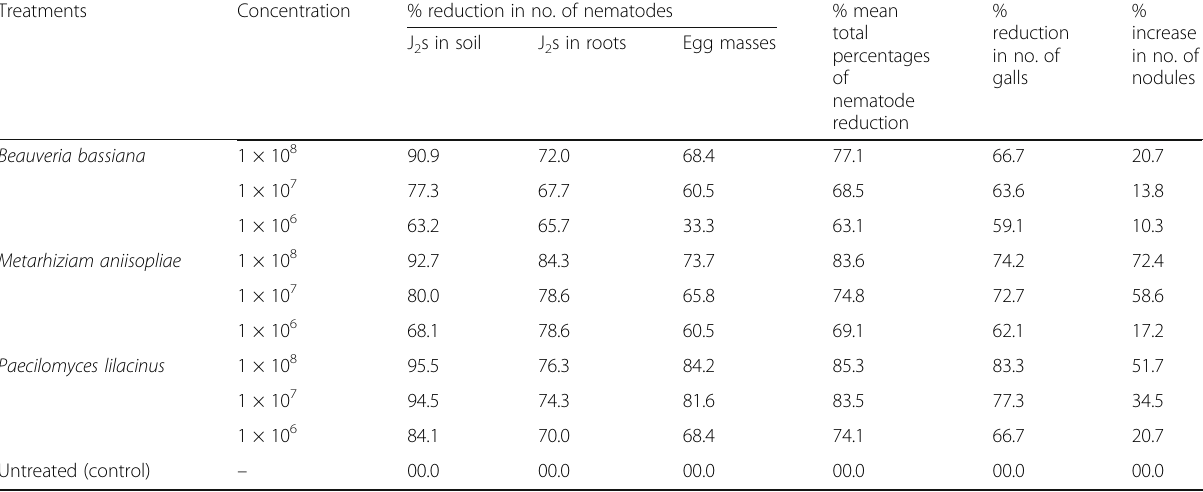
Table 7 Percentages of reduction of number of the root-knot nematode, Meloidogyne incognita infecting cowpea, number of galls and percentages of increase of number of nodules as affected by three spore concentrations from Beauveria bassiana , Metarhiziam aniisopliae , and Paecilomyces lilacinus Treatments Concentration % reduction in no. of nematodes % mean